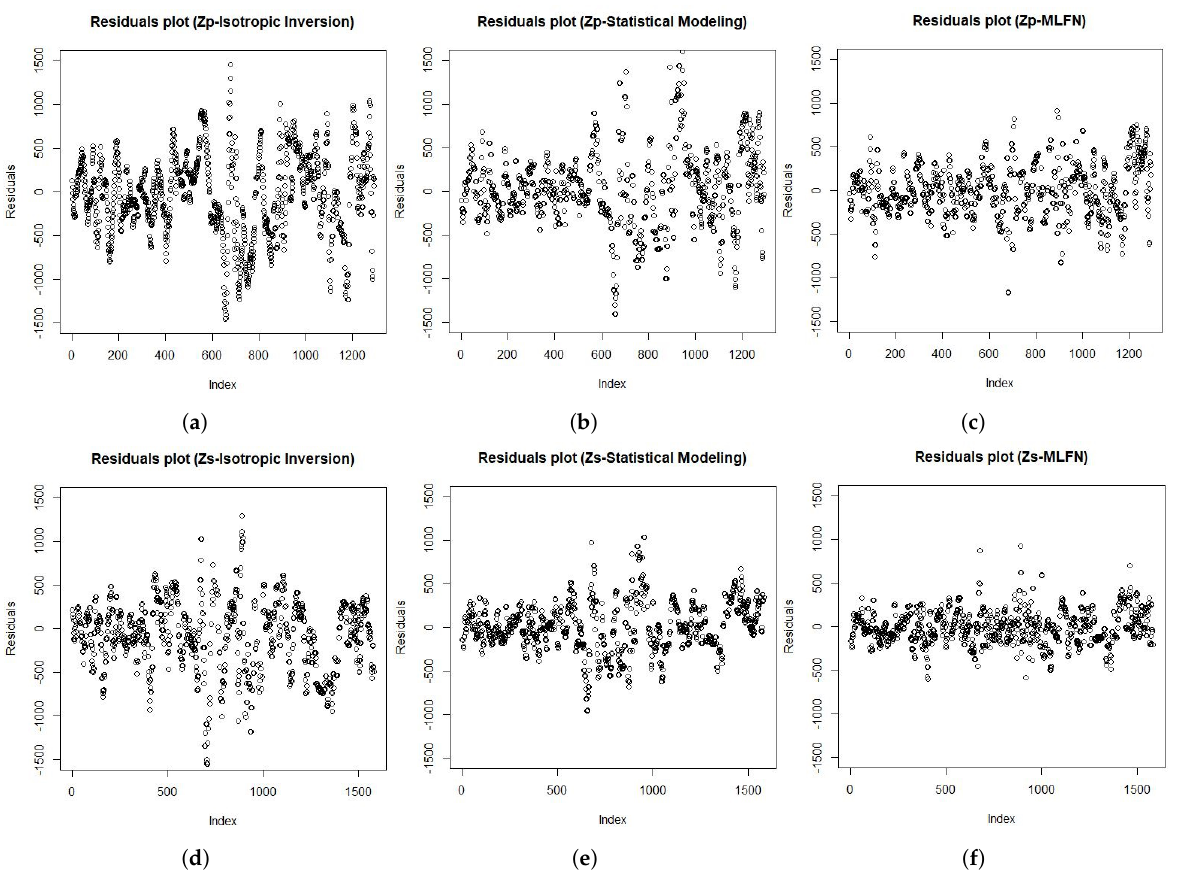
Figure 20. The residual plots of the isotropic inversion, statistical modeling, and MLFN for each of the zero-offset Z P ( a – c ) and Z S ( d – f ), where the number of samples of each model is on the X-axis and residuals are on the Y-axis.